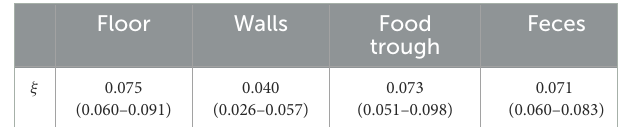
TABLE 1 The median and 95% credible interval of ξ